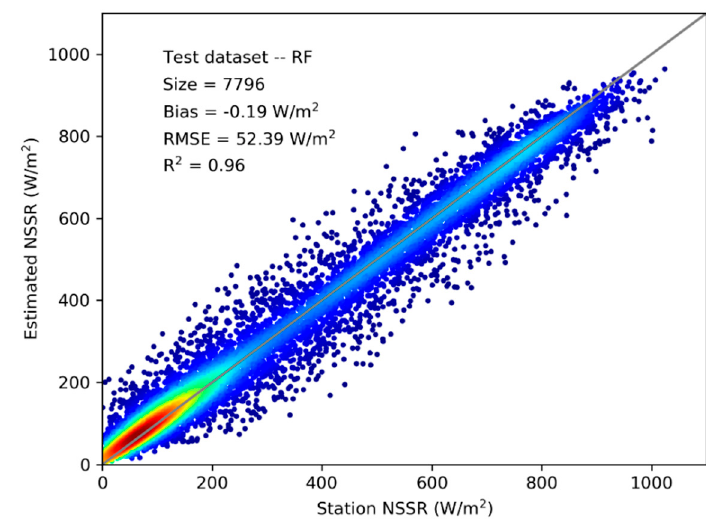
Figure 5. Comparison of NSSR estimated by the RF method with in-situ observations in the test dataset.